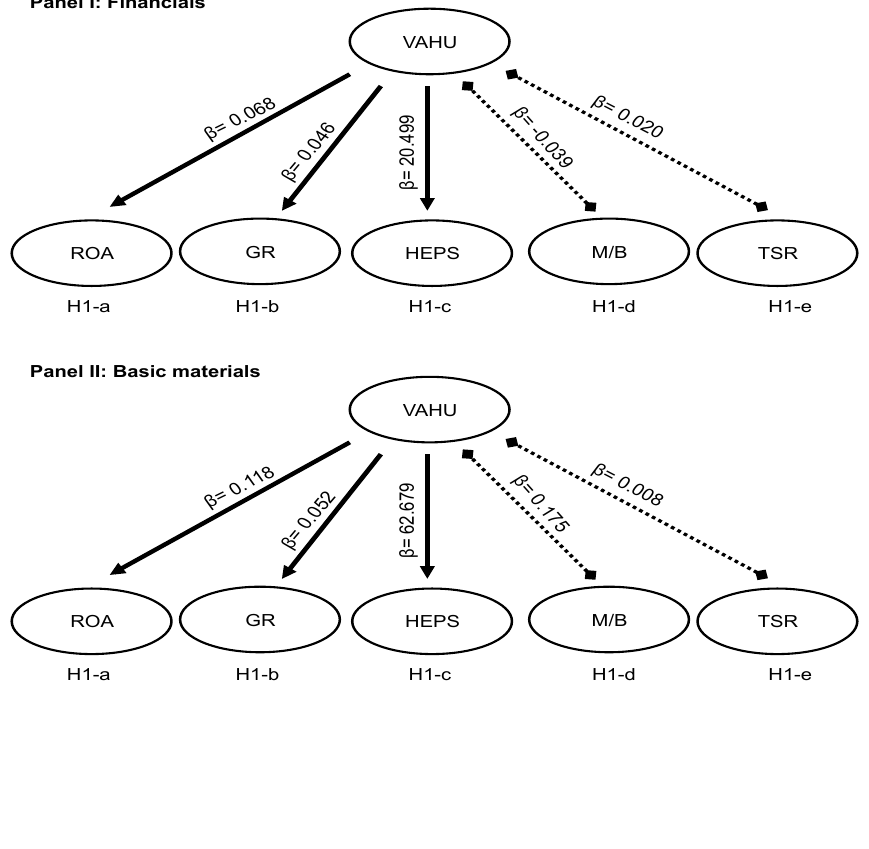
Regression of corporate performance on human capital efficiency